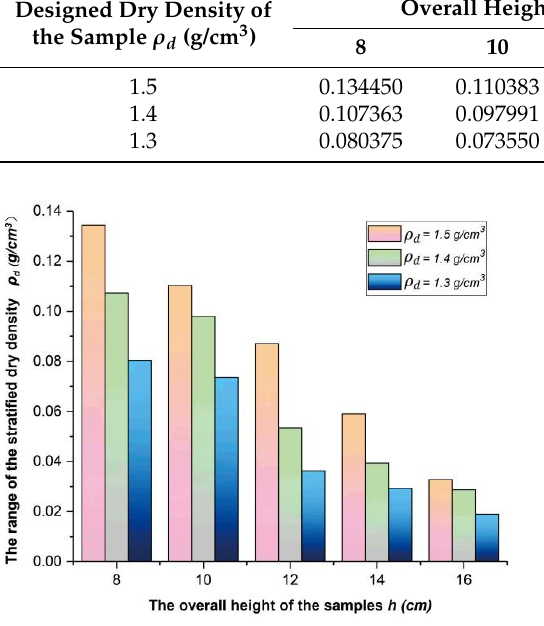
Table 2. The range of the dry densities of the stratified samples. Designed Dry Density of